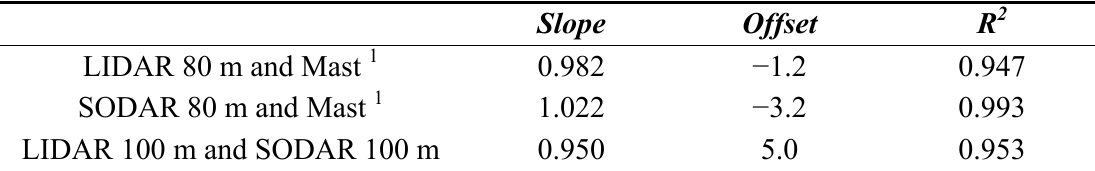
Table 3. Regression Results for Wind Direction